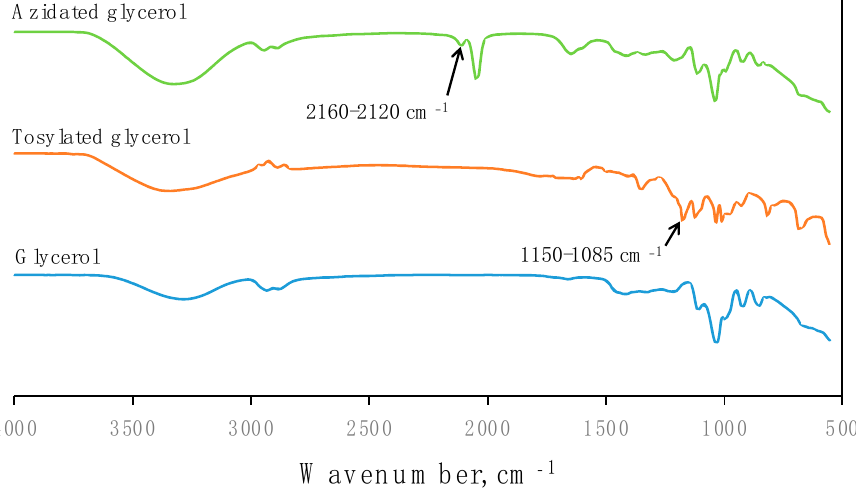
Figure 4. FTIR spectra of glycerol, tosylated glycerol, and azidated glycerol.